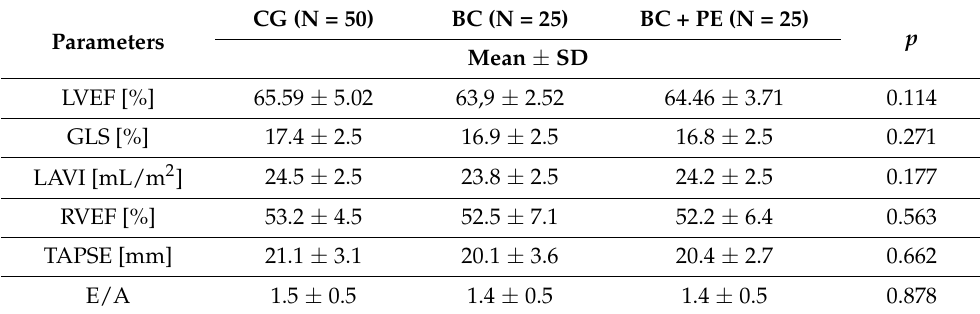
Table 3. Results of the cardiac function assessment between study